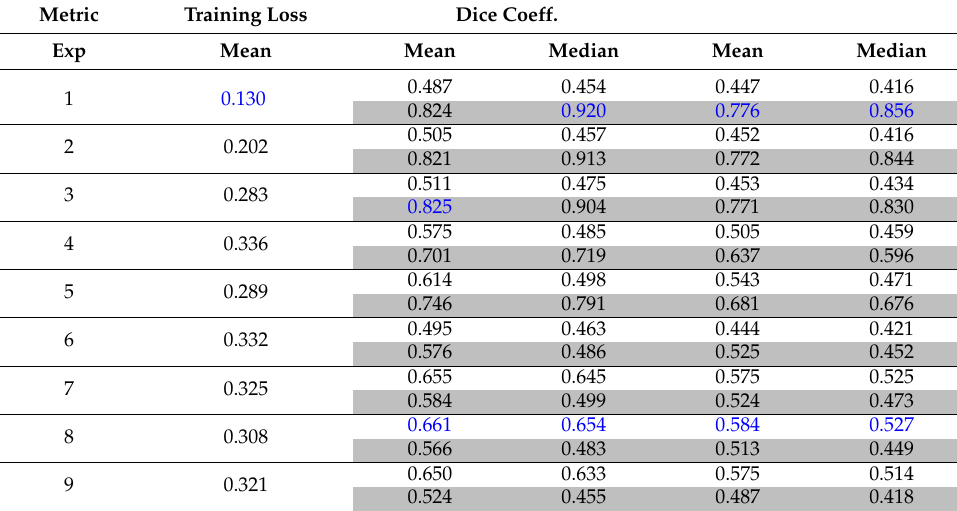
The scores displayed with white background denote results from Test Set A , and those with gray tinted back- ground indicate results from Test Set B . The best performances within each test set and metric are specified with blue